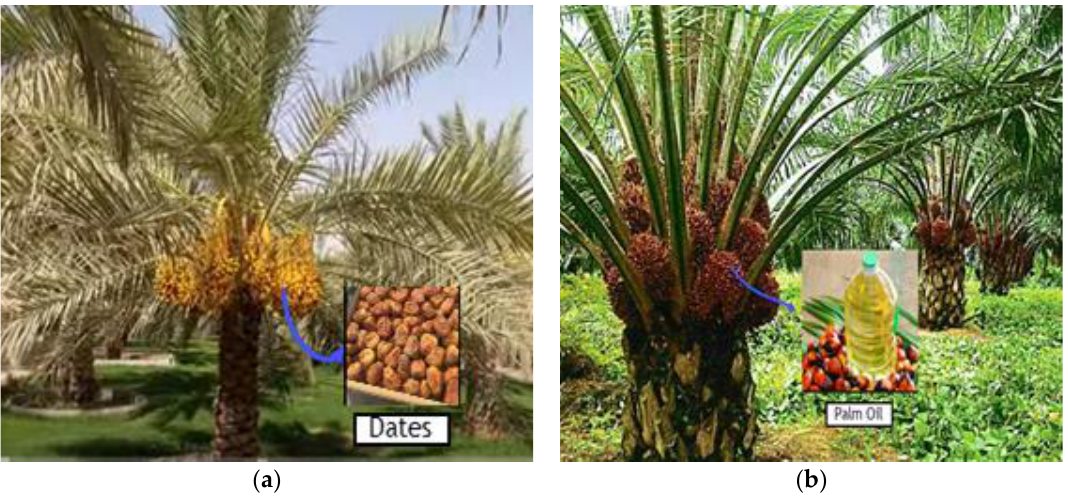
Figure 1. The two main types of palm trees: ( a ) date palm and ( b ) oil palm.